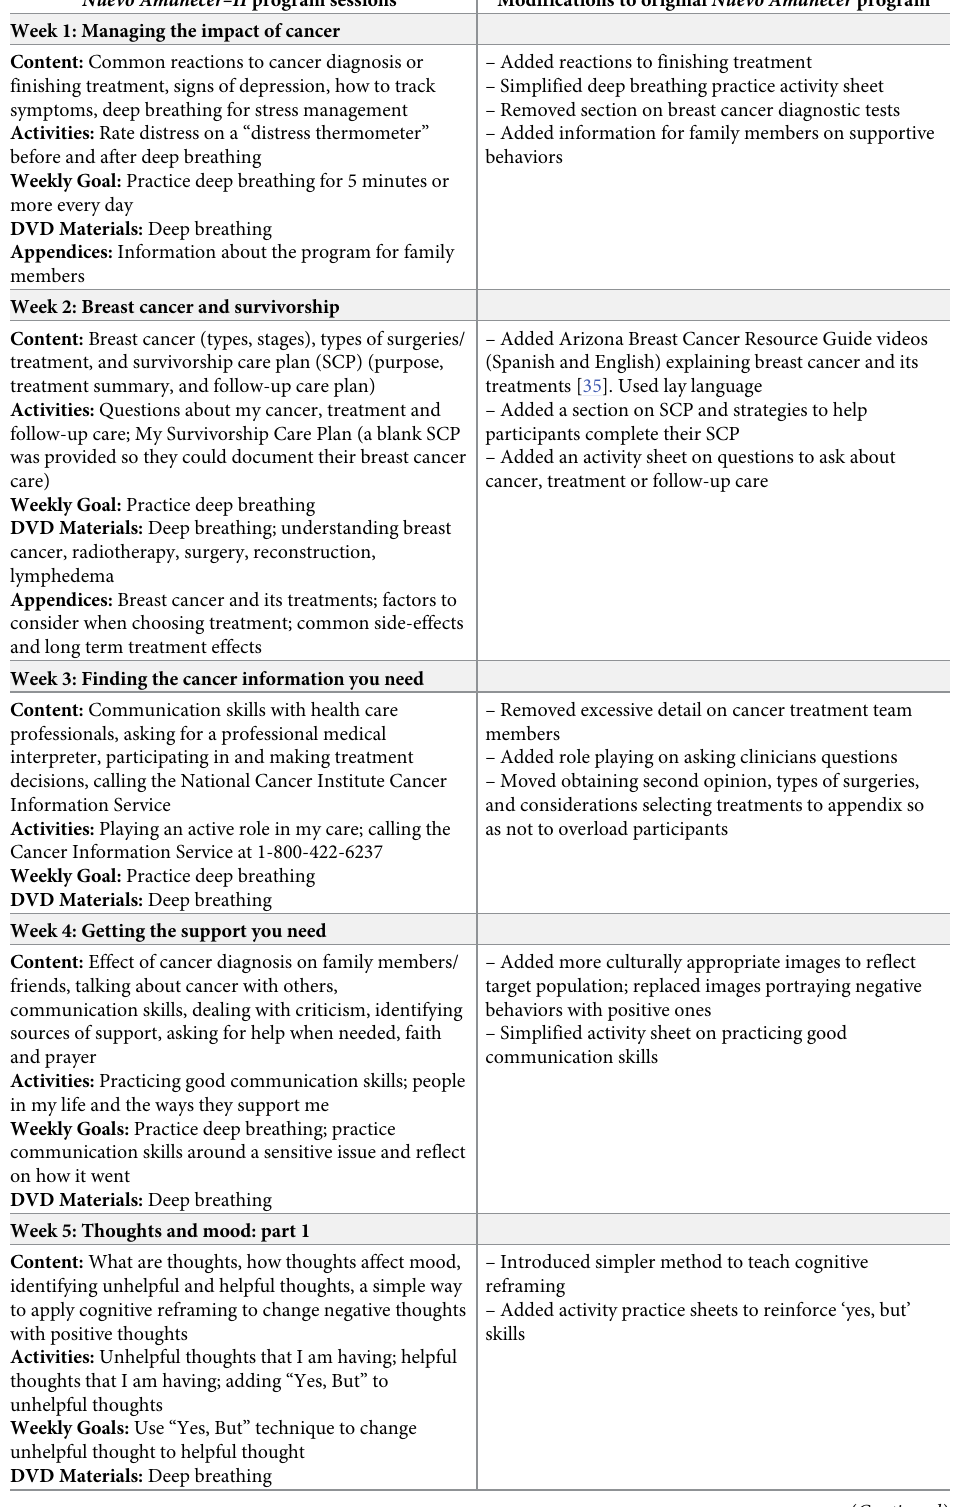
Table 1. Content of Nuevo Amanecer-II intervention and modifications to the original